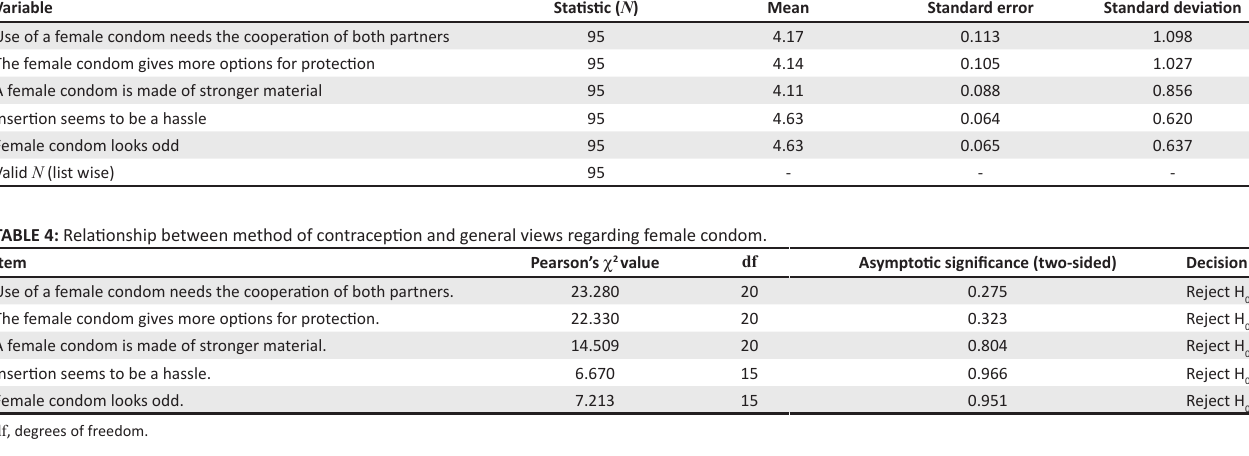
TABLE 3: General views about female condom. Variable Statistic ( N )